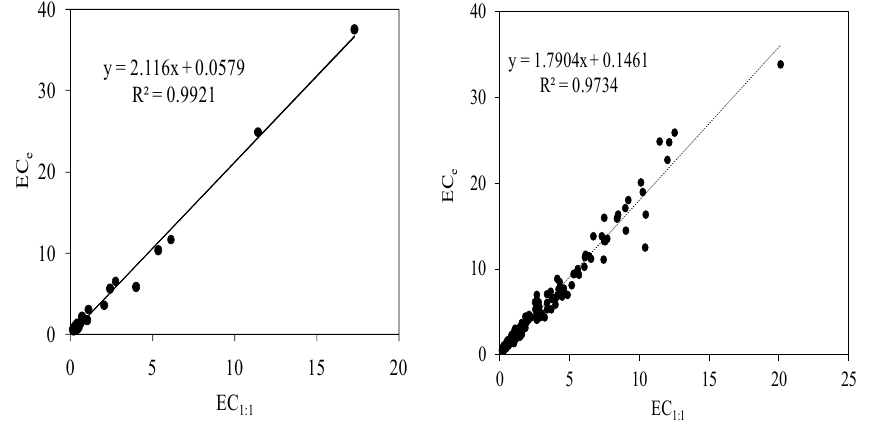
Figure 2. The EC e = f (EC 1:1 ) and EC e = f (EC 1:5 ) relationships for combined soil texture data (N = 198). Dark circles for EC e = f (EC 1:1 ) and open circles for EC e = f (EC 1:5 ) relationships. The values of EC in dS m − 1 ). The studied soil samples were grouped according to their Saturation Percentage (SP%) values, and two EC e = f (EC 1:1 ) linear curve fitting prediction equations were produced (Figure 3).